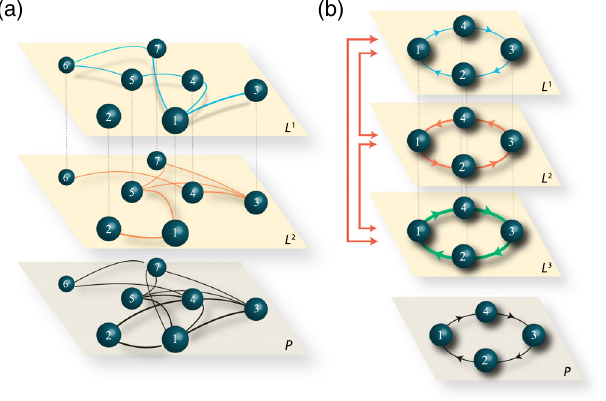
FIG. 1. (a) A multiplex network with L ¼ 2 layers ( L 1 and L 2 ) and K ¼ 7 nodes. A random walker diffusing over this structure generates a two-dimensional time series f X ð t Þ ; l ð t Þg N , where t ¼ 1 X ð t Þ and l ð t Þ are the vertex and layer locations of the walker at time t . In many real-world cases, the layer indicator l ð t Þ is hidden, and one has access only to f X ð t Þg N , i.e., to the series of t ¼ 1 states of the walker on the projected network ( P ) shown in the bottom of the figure. For L > 1 , the resulting trajectory is non- Markovian: We rely on this Markovianity-breaking phenomenon property to detect multiplexity and to provide an estimate of the number of layers in the system by observing only f X ð t Þg N . t ¼ 1 (b) Simple canonical model where we fix a prior on the topology of each layer: a cycle graph with homogeneous transition rates, with uniform interlayer transition rates. This model serves as a basis for a generic stochastic decomposition of non-Markovian dynamics on the aggregated